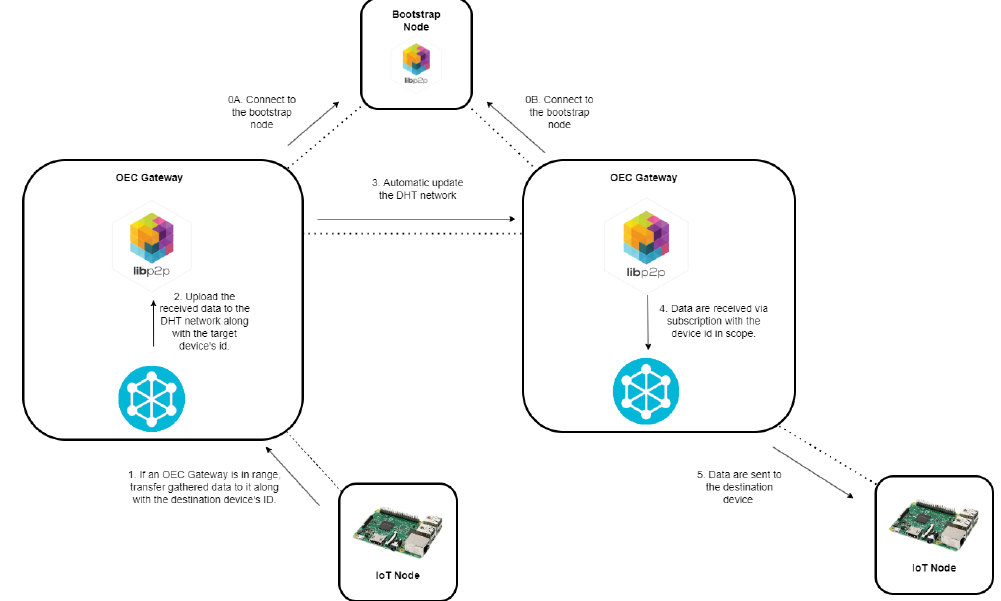
Figure 7. Step-by-step process for exchanging data between two opportunistic IoT